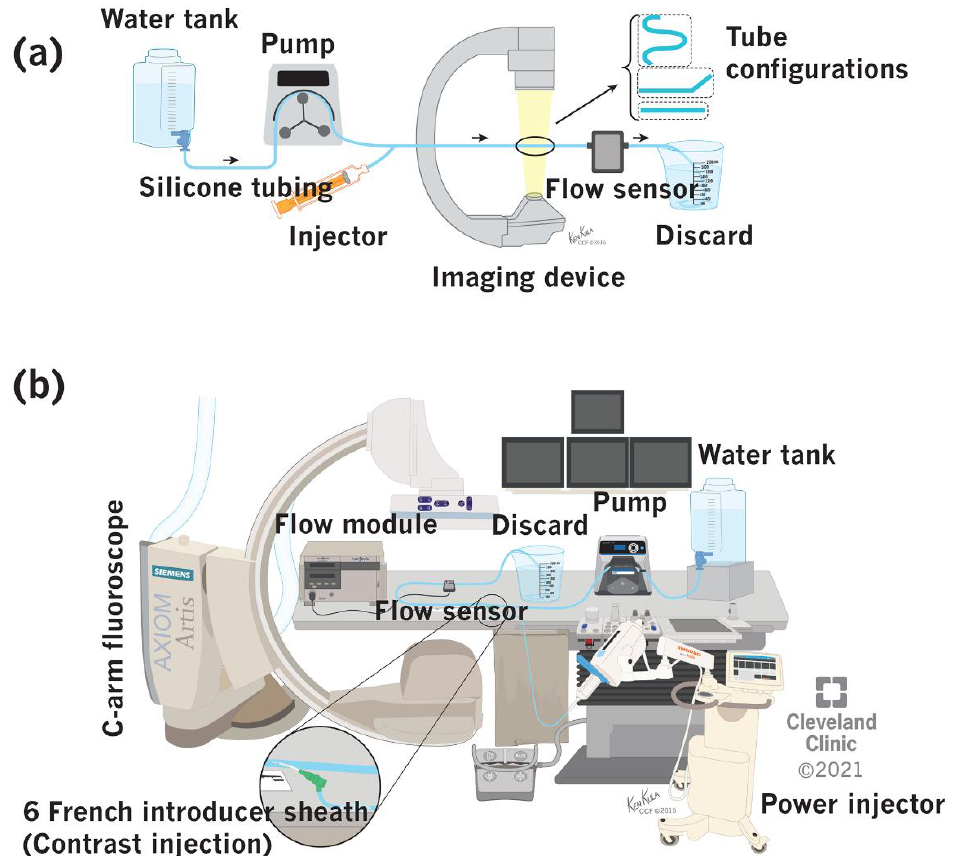
Figure 3. Benchtop set up for simulation of blood flow in a flow phantom model. ( a ) Block diagram (arrows indicate direction of flow), ( b ) experimental set up. (Reprinted with permission, Cleveland Clinic Center for Medical Art & Photography © 2021. All rights reserved).